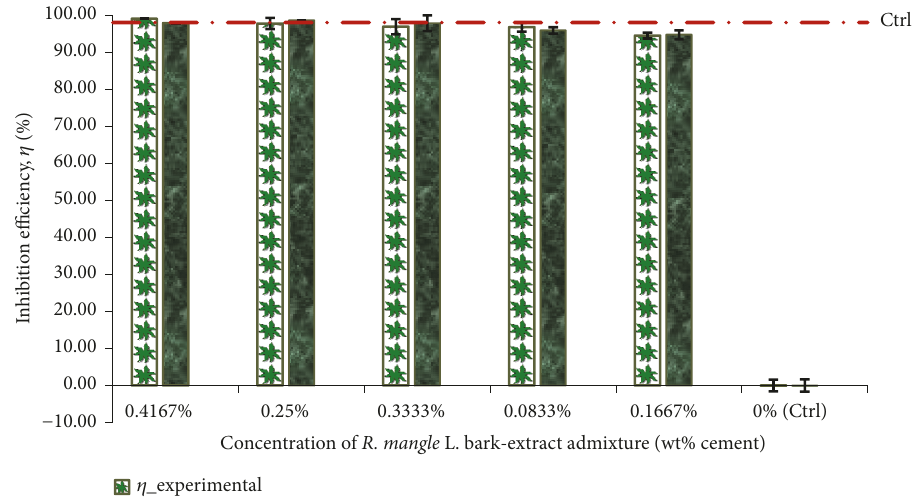
Figure 4: Plots of corrosion-inhibition efficiency for the specimens of steel-reinforced concrete studied.